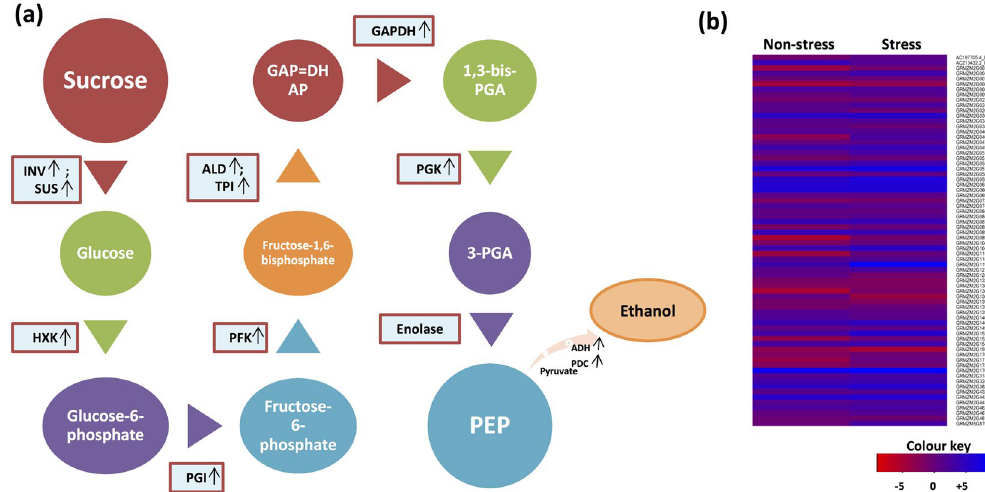
Figure 3. Energy-production pathways regulated in waterlogging tolerant genotype under stressed condition. (a) Energy-production pathways regulated during waterlogging stress. Here arrows denote the expression level of waterlogging responsive genes in maize roots. Expression level marked here includes greater than 2 fold change. Refer the paper for abbreviations. (b) Heatmap of energy-production pathway regulating genes. X-axis denotes non-stress and stress conditions. Y-axis denotes the gene models of energy-production pathway genes. Refer Table S4 for details of energy-production pathway